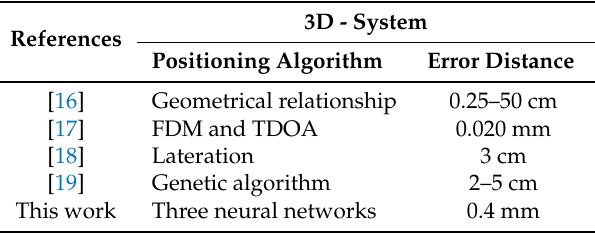
Table 6. Comparitive study in terms of